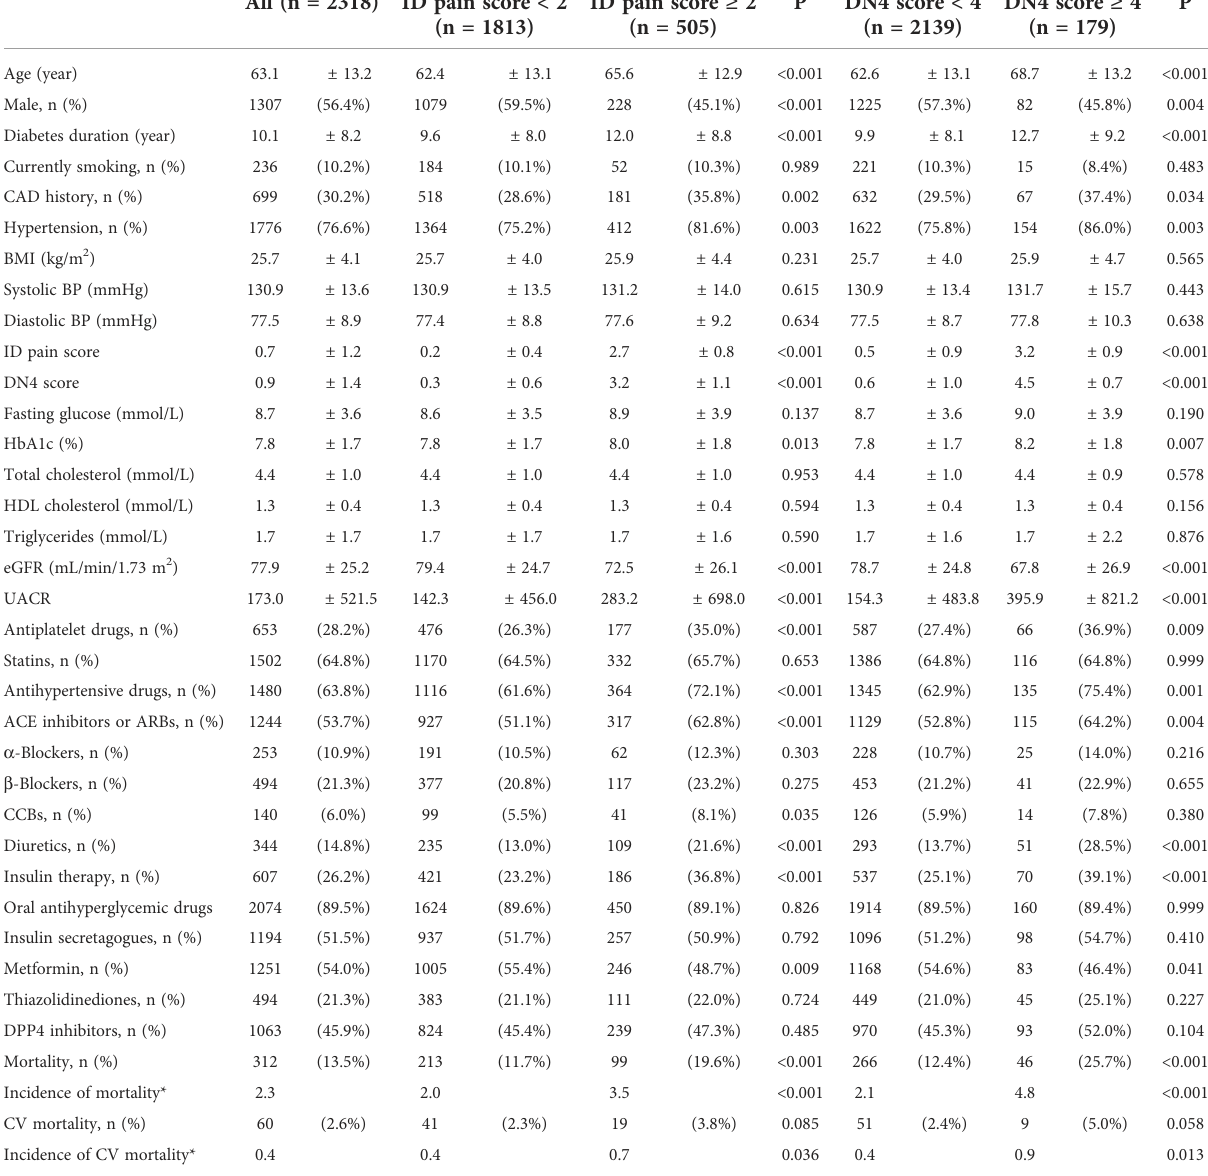
TABLE 1 The baseline characteristics of all patients, categorized by peripheral neuropathic pain